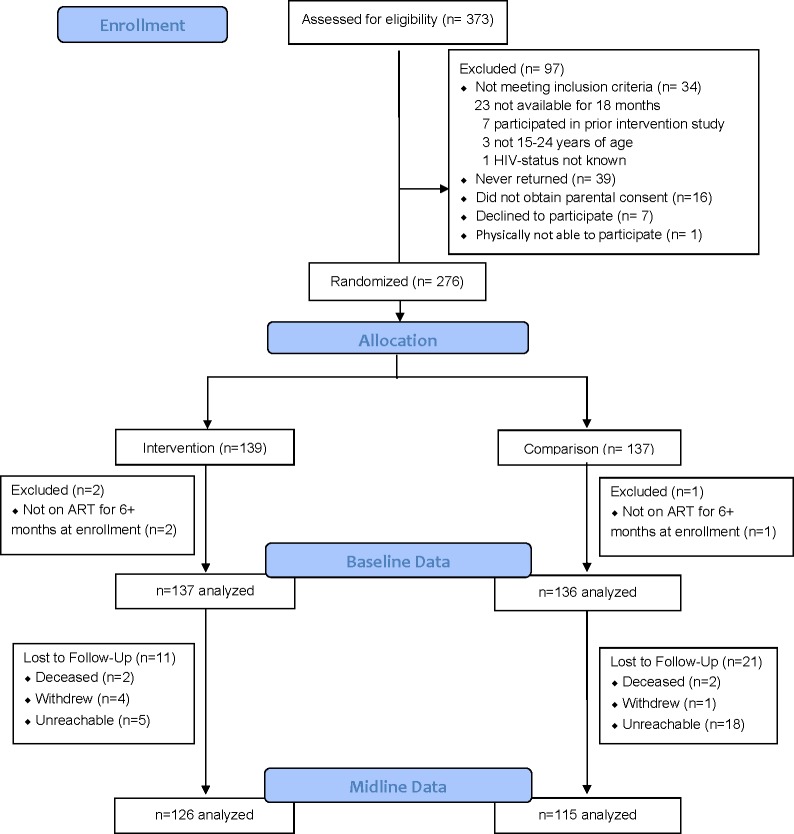
Consort diagram.